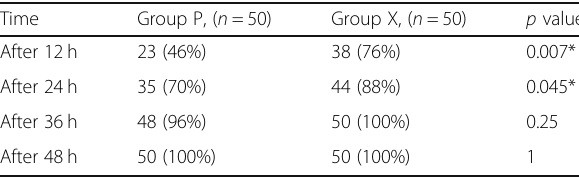
Table 5 Comparison between the two groups as regards the number (percentage) of patients who reached therapeutic